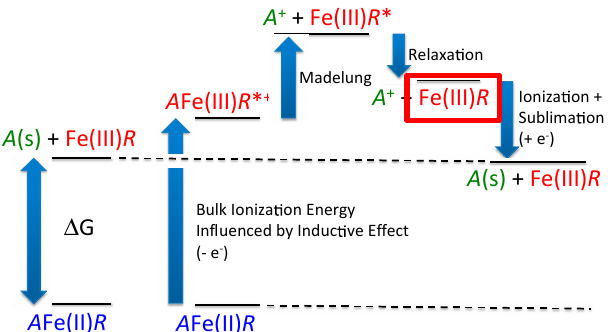
Figure 1. A Born–Haber cycle for the definition of voltage generation in cathode materials based on Fe 3+ /Fe 2+ redox couple. The notations R and R * represent relaxed and unrelaxed frameworks, respec- tively. Bulk ionization energy, which is closely related to the inductive effect, is an approximation (electronic part) but is not identical to Δ G.